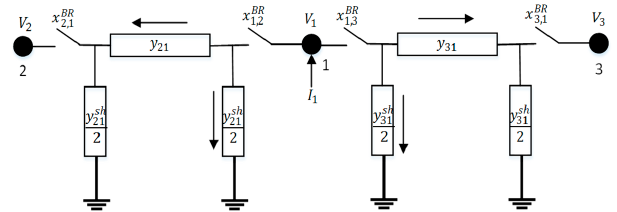
Figure 8. Three-node example to illustrate power flow constraints for droop-controlled microgrids.